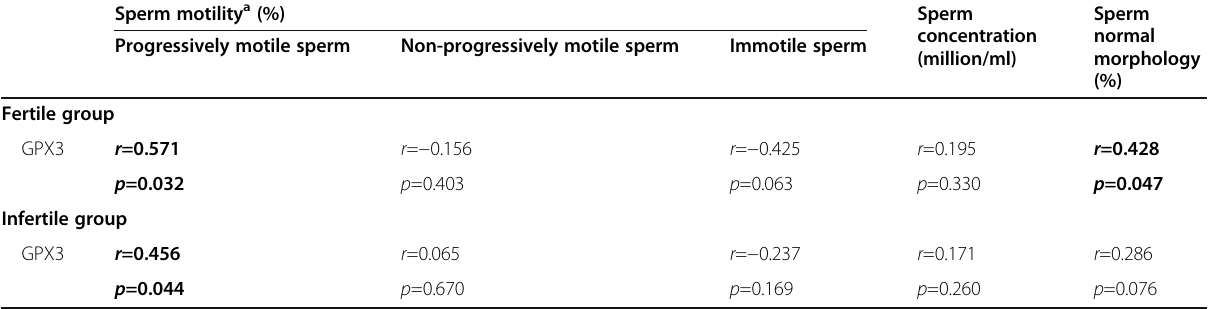
Table 3 Correlation between semen profile and levels of glutathione peroxidase 3 (GPX3) in the seminal fluid of fertile ( n =100) and infertile ( n =100) men